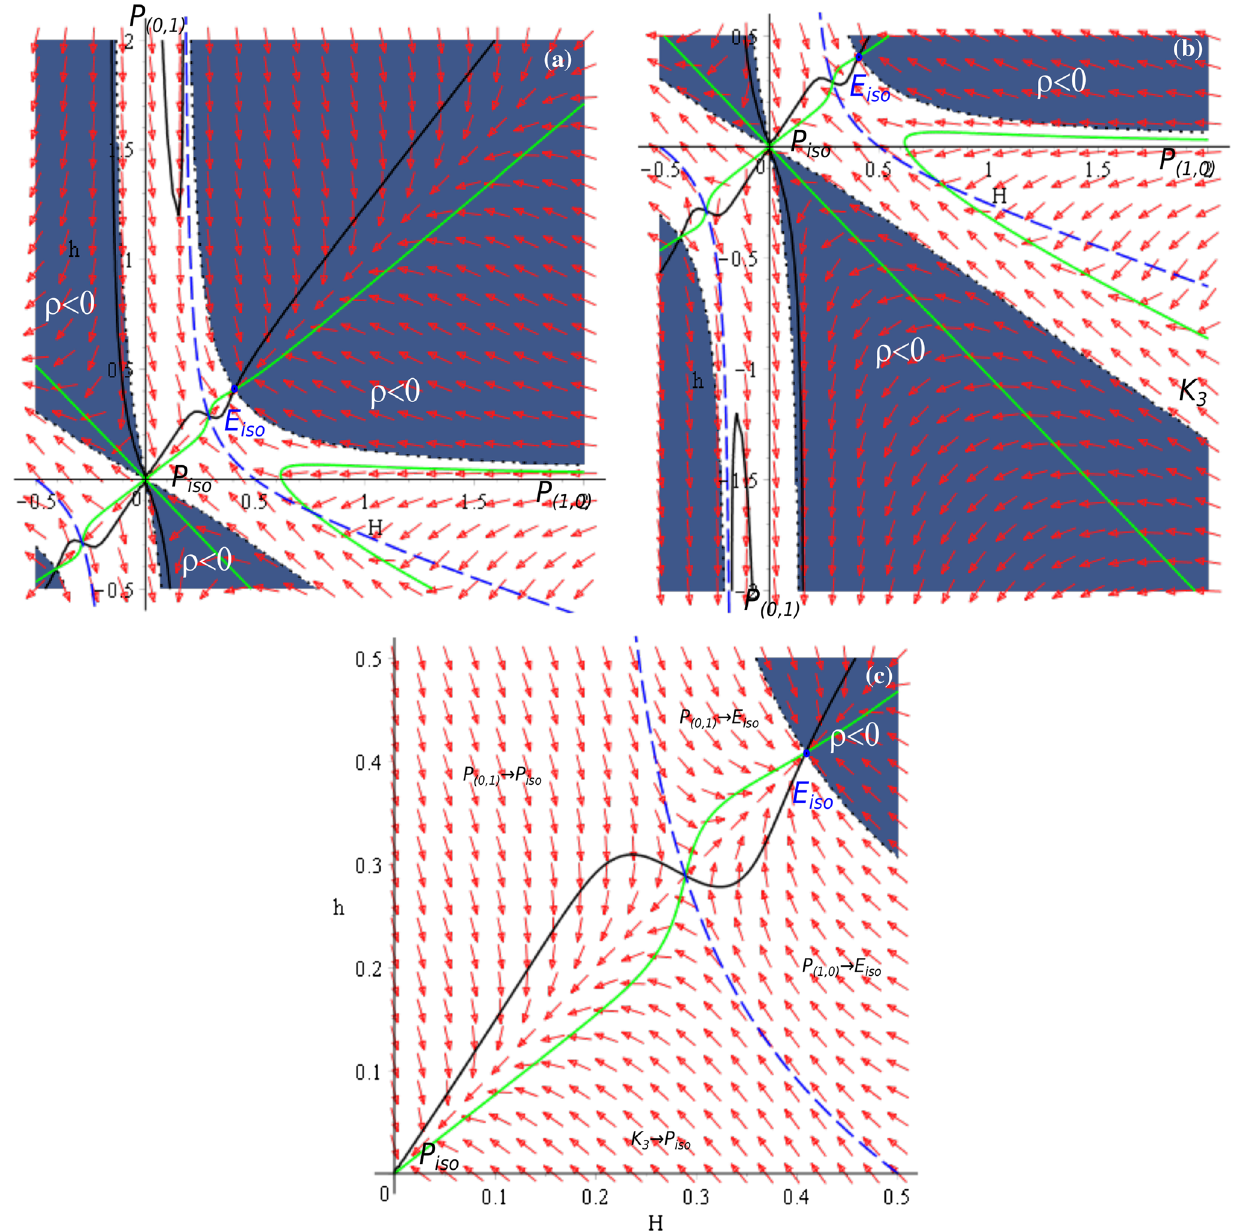
Fig. 8 Phase portraits for D = 2 α < 0, ω < 0 case: focus on h > 0 regimes on a , focus on h < 0 regimes on b and the central area between P iso and E iso on c . Dashed blue line corresponds to the ρ 0 from (21).